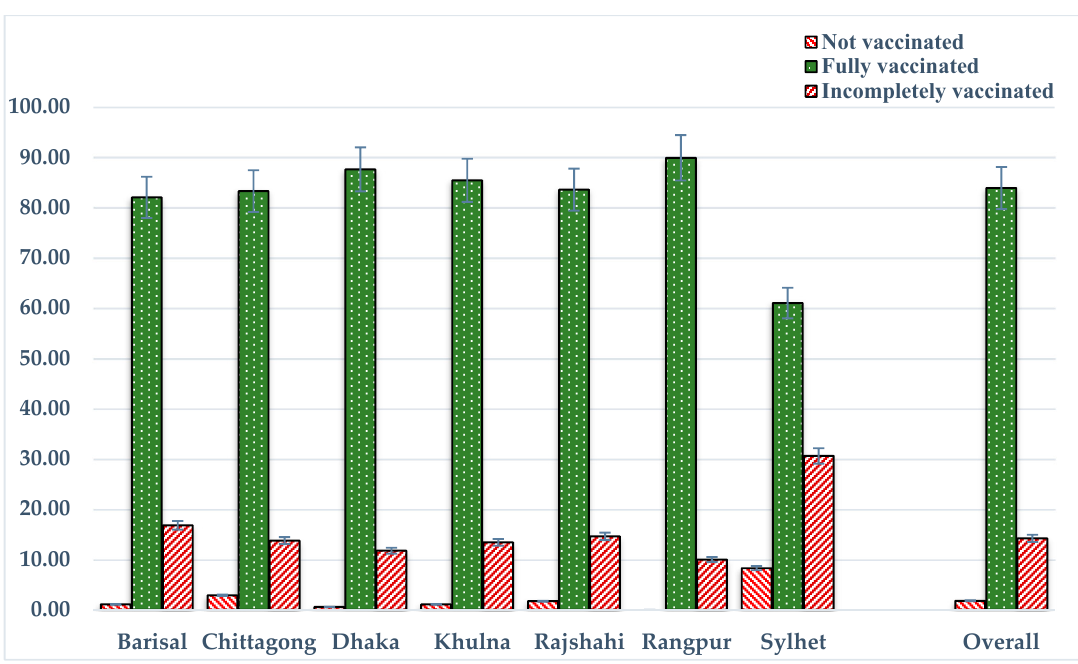
Figure 1. Vaccination status across divisions.